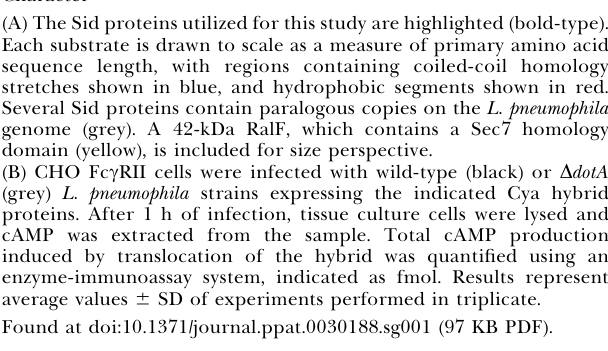
Figure S5. Model Depicting the Contribution of IcmSW to the Recognition of Effector Proteins by the Dot/Icm Transporter in L. pneumophila IcmS (red) and IcmW (blue) form a complex in the L. pneumophila cytoplasm. Each factor harbors a binding activity on effectors, where